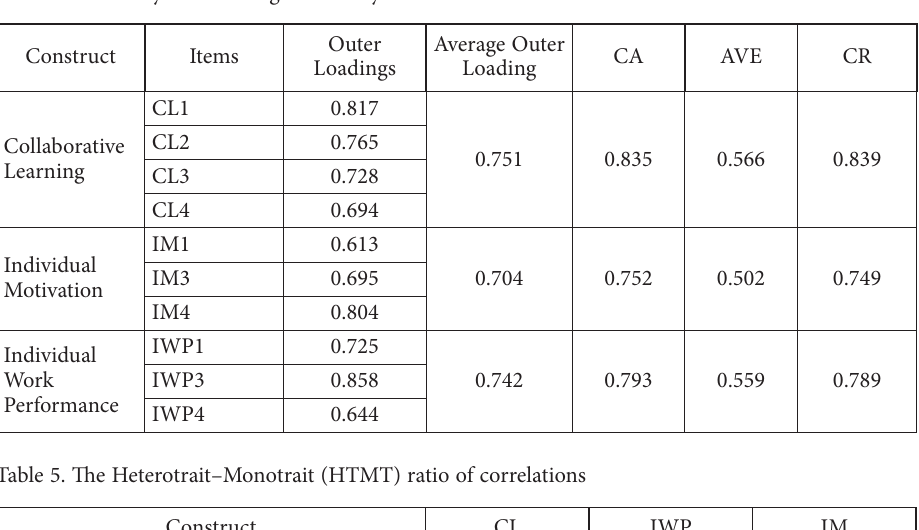
Table 4. Reliability and convergent validity